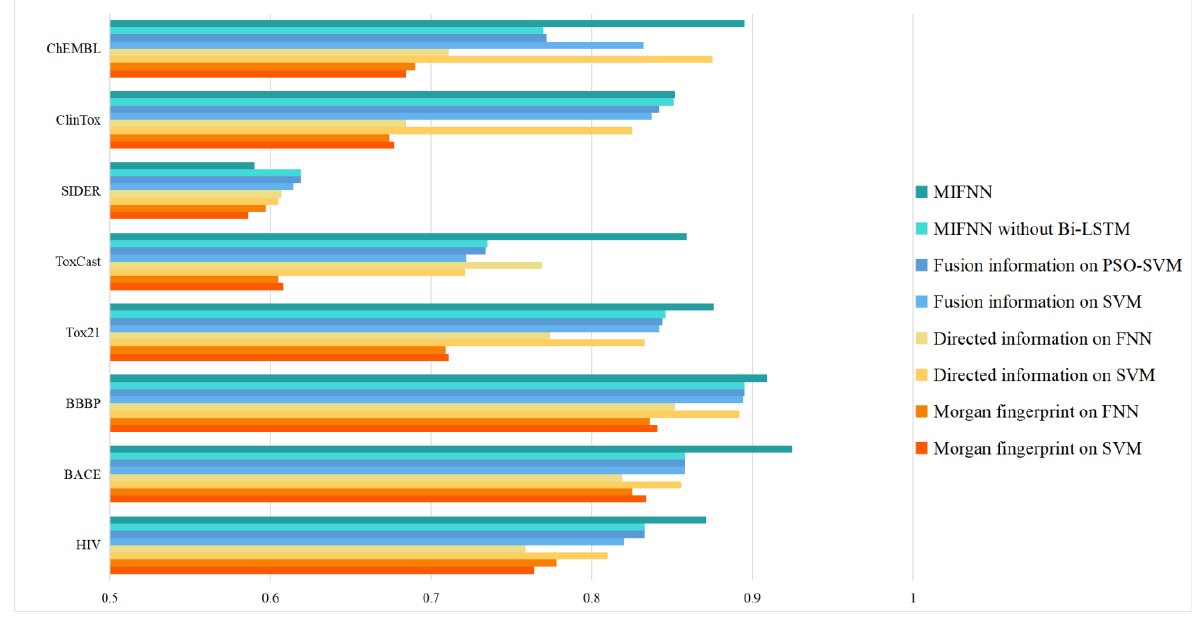
Figure 8. Model optimization results.